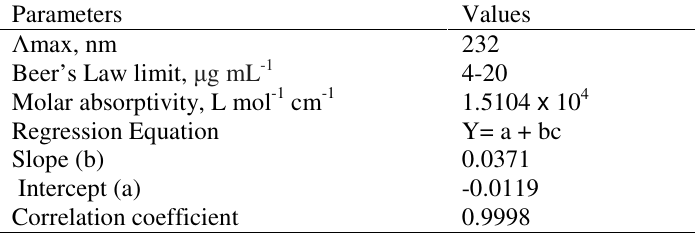
Table 1 . Optical characteristics of proposed method